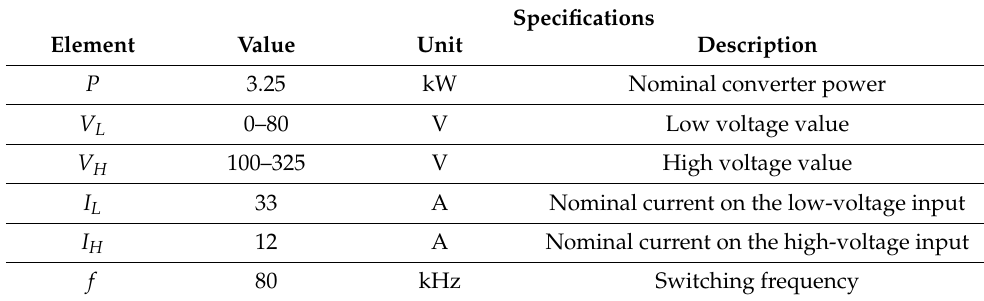
Figure 23. BHSC prototype.